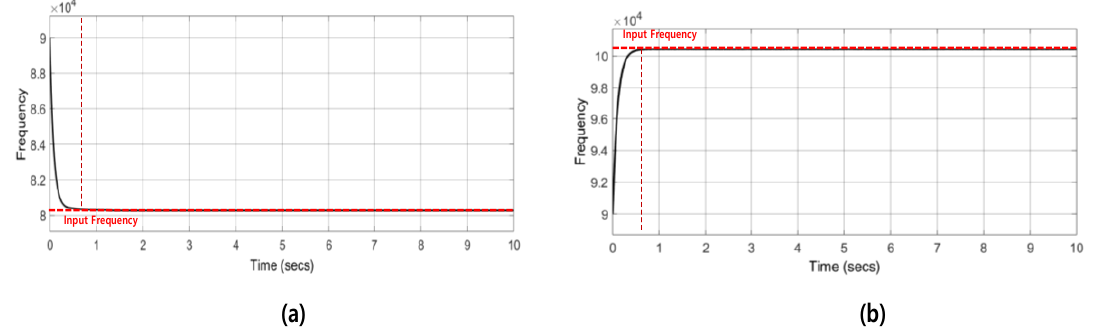
Figure 12. SOGI-FLL step response (Frequency estimated value); ( a ) 80 kHz input frequency; ( b ) 100 kHz input frequency.